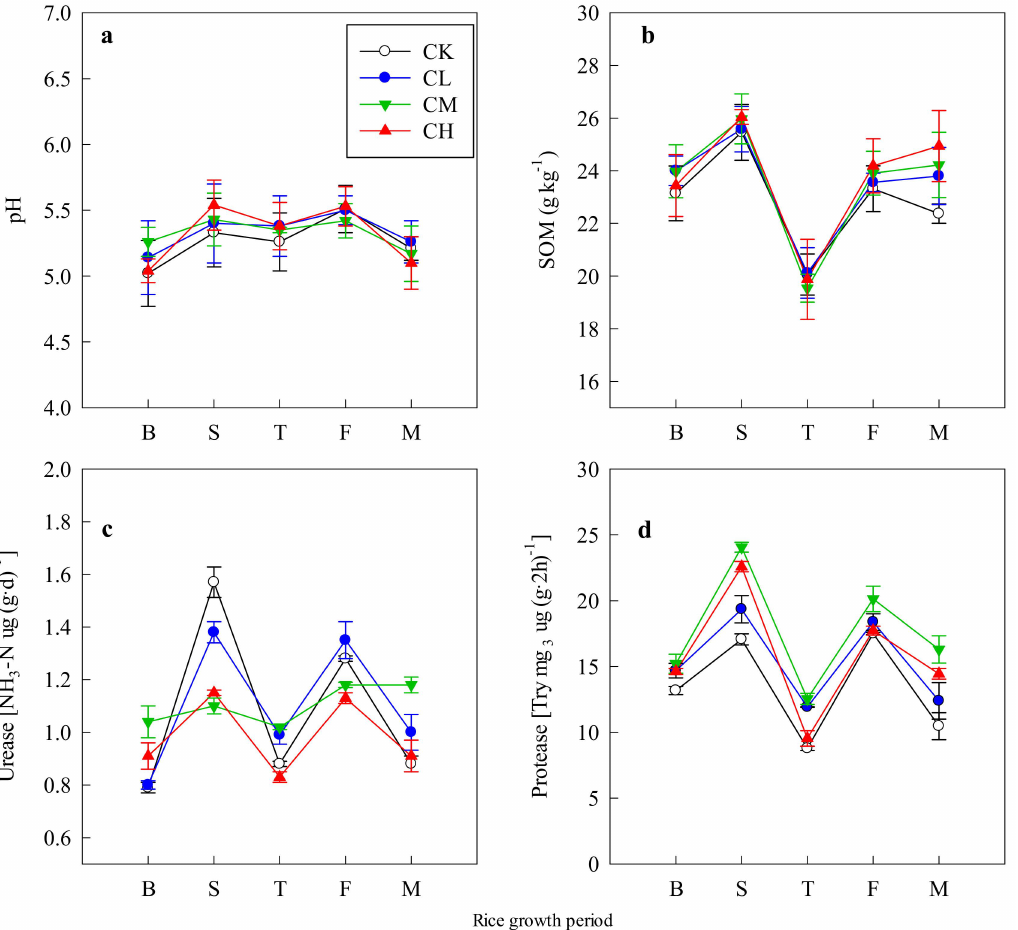
Figure 7. Soil pH ( a ), SOM ( b ), urease activities ( c ), and protease activities ( d ) under different fertilization treatments during different rice growth stages. Note: CK: chemical fertilizer, CL: the low amount of CMV, CM: the medium amount of CMV, CH: the high amount of CMV, B: background soil, S: seedling stage, T: tillering stage, F: flowering stage, M: maturity stage. The error line indicates a standard error (n =